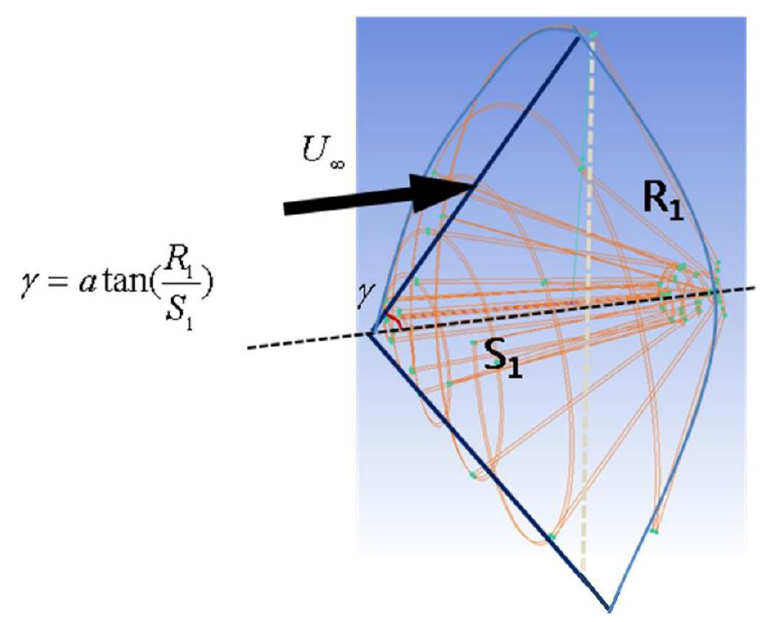
Figure 2. Shape parameter of the Archimedes spiral wind turbine